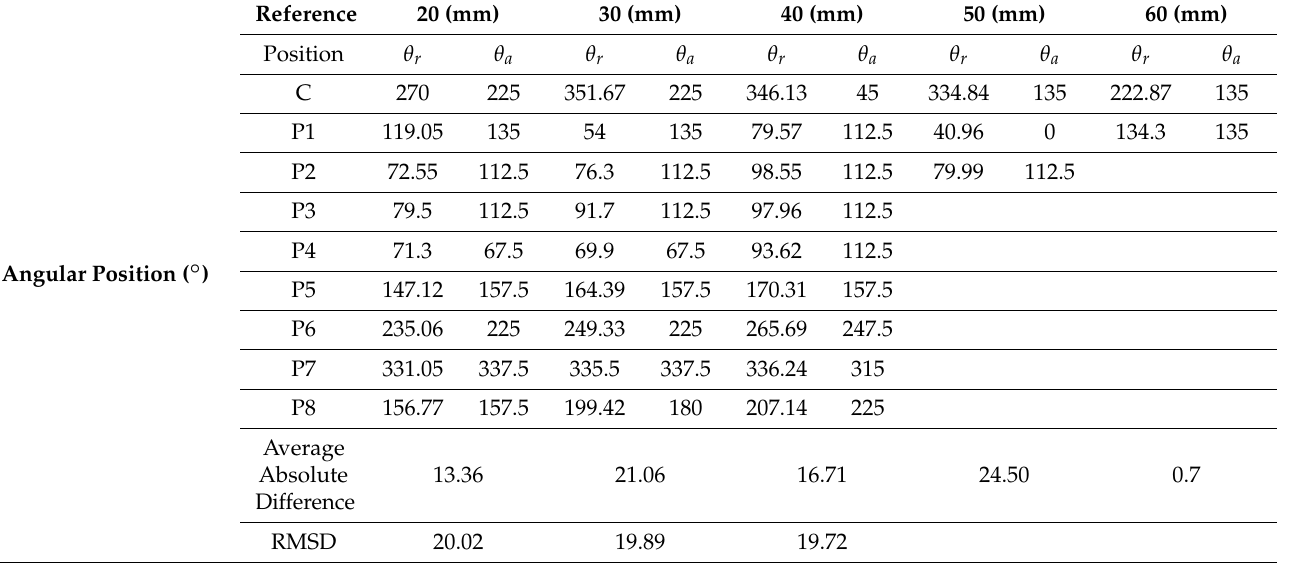
Table 4. Azimuthal position obtained for different concentric and eccentric cases. The first row corresponds to the cases where the phantoms were placed very close to the center of the pipe. Maximum absolute difference and RMSD are calculated for the 8 other positions except P1 of 30 mm case. RMSD not calculated for 50 mm and 60 mm